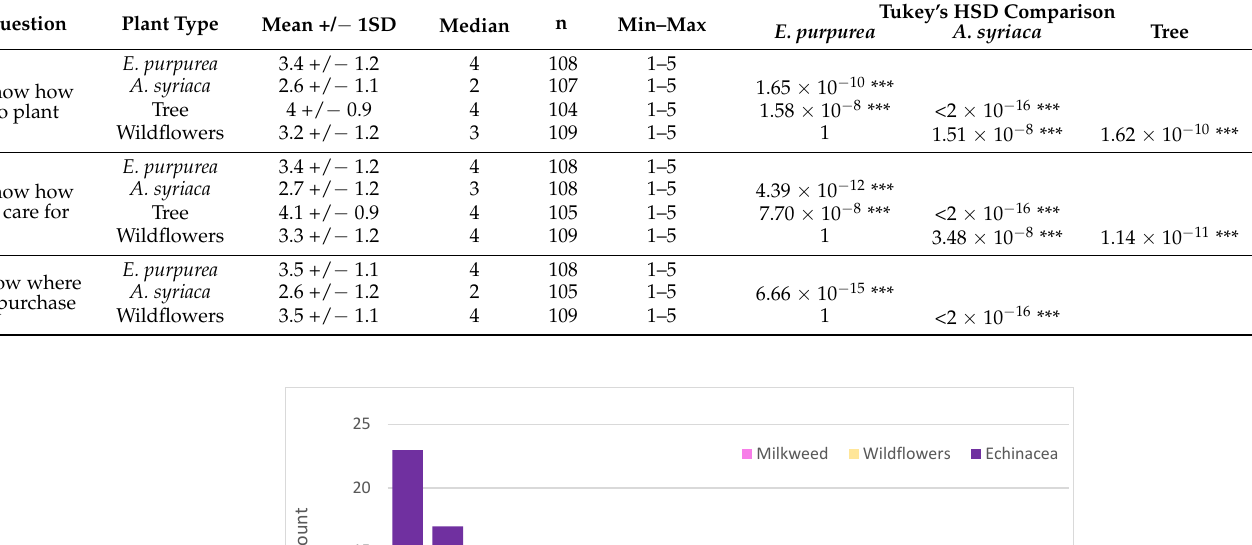
Table 3. Statistical comparisons for the reported knowledge of how to plant, care for, and purchase for the different native plants shown in the survey as well as for trees. Mean +/ − 1 standard deviation (SD) and median for reported knowledge of where to purchase, how to plant, and how to care for purple coneflower, common milkweed and wildflowers ( Echicanea purpurea , Asclepias syriaca , and multiple spp . of wildflowers, respectively). Note that the “where to purchase trees” question was not included in the survey instrument. We conducted a one-way repeated-measures ANOVA to examine whether the mean reported knowledge about how to plant, E. purpurea , A. syriaca , and wildflowers were different. The same analyses were conducted for the other knowledge statements, i.e., “know how to care for” and “know where to purchase”. Higher values indicate that the respondent believes they are more knowledgeable. The scale varies from 1 to 5, with 5 indicating that the respondent strongly agrees with the statement (e.g., “I know how to care for wildflowers”). A value of one indicates the respondent strongly disagrees with the statement so that a value of three is neutral (“Neither agree nor disagree”). The p values reported for the post hoc test of multiple comparisons are Bonferroni adjusted. The number of respondents who answered each question is provided in the column labelled n. Asterisks *** denote 0.1% levels of significance.